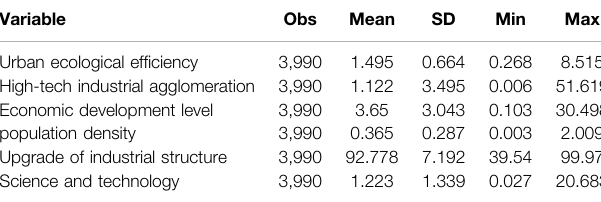
TABLE 3 | Descriptive statistics of major